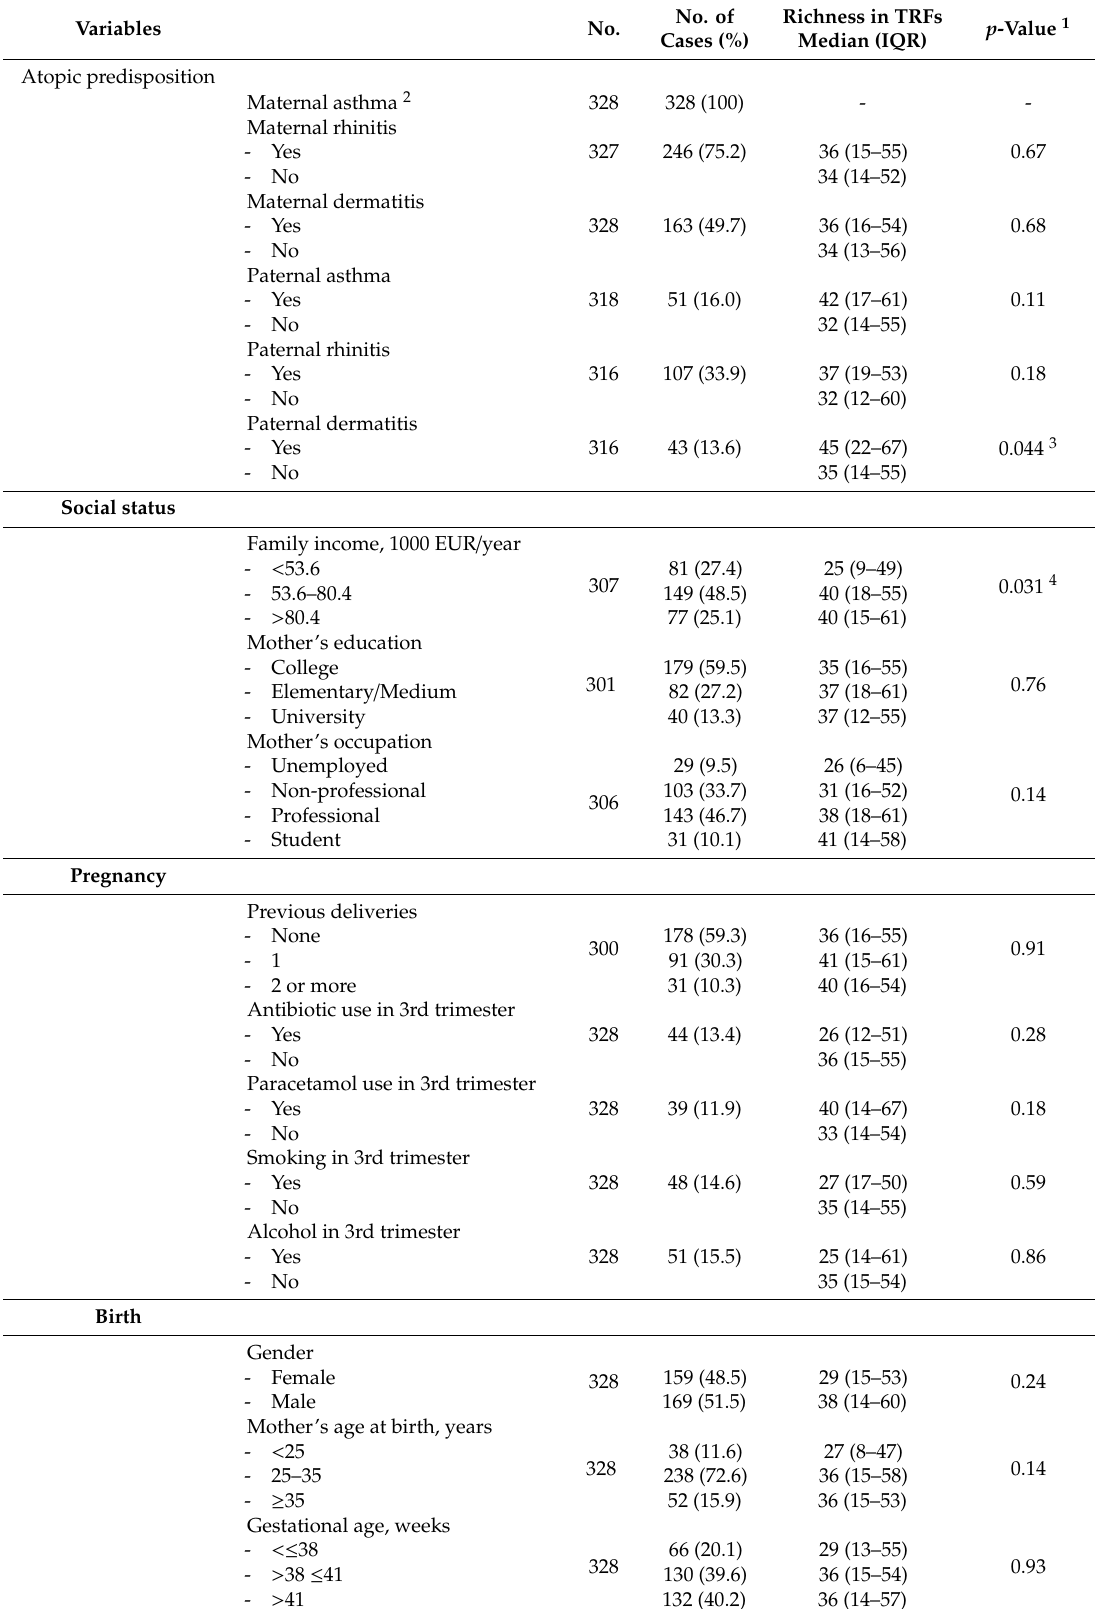
Table 1. Associations between perinatal risk factors and TRF richness in the nasopharynxes of asymptomatic